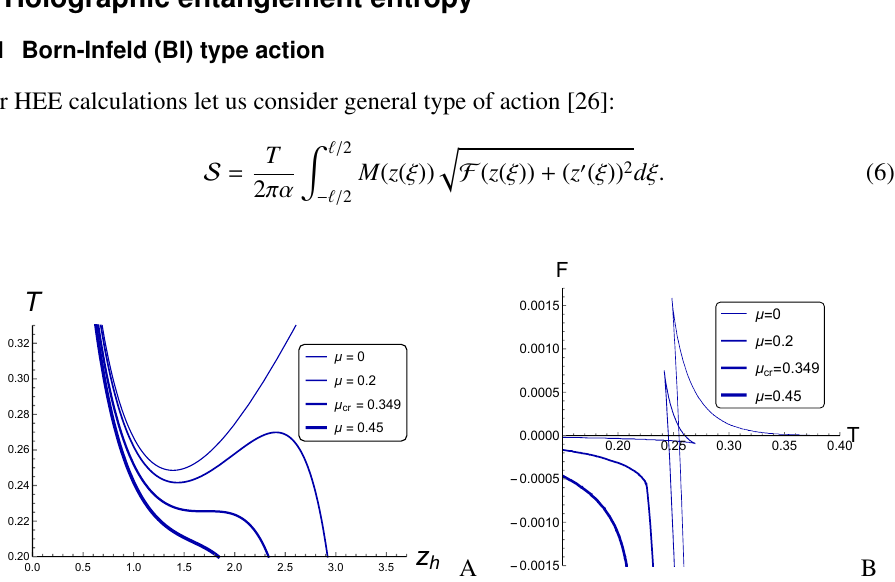
Figure 1. A) The temperature T dependence on z h for c = energy F ( T ) for c = 1, ν = 4 . 5 and di ff erent µ . −